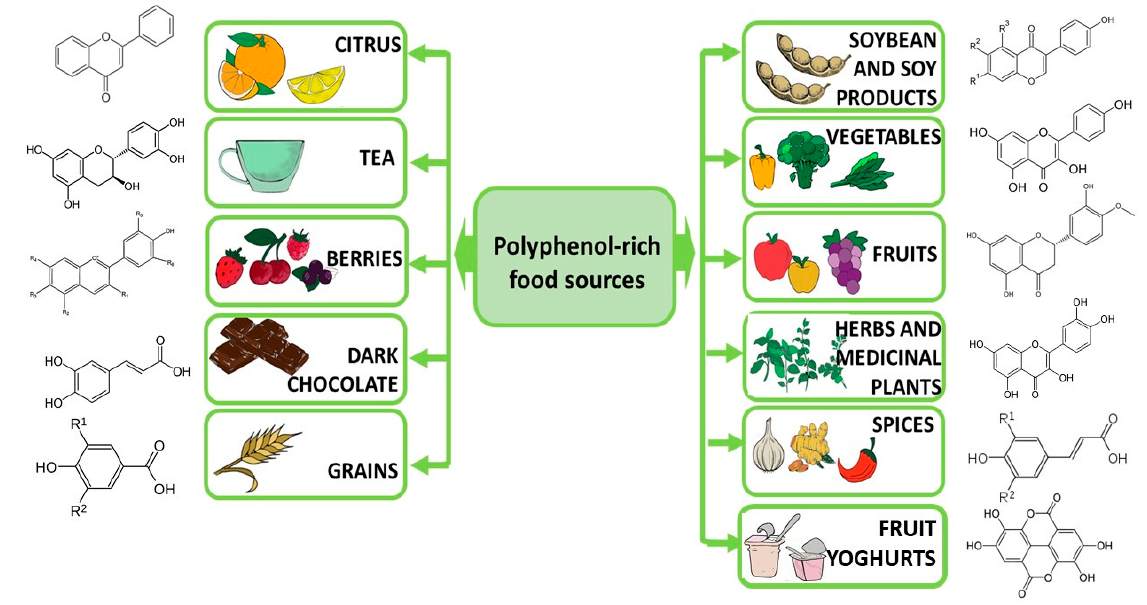
Figure 2. Dietary sources of polyphenols.